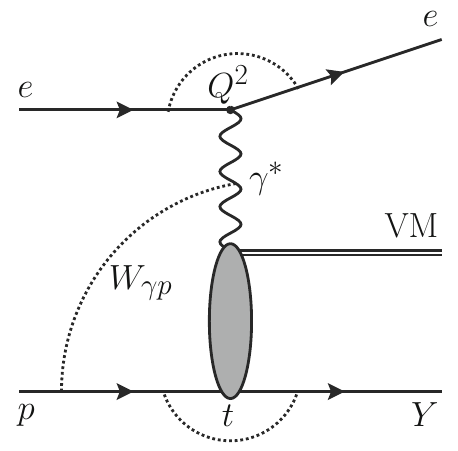
Fig. 1 Diffractive vector meson